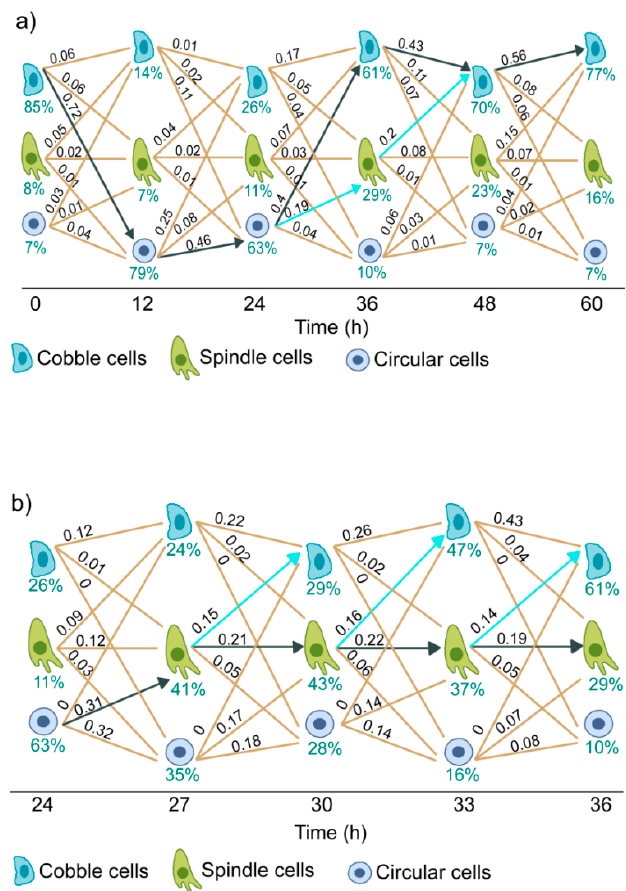
Figure 4. Cell state transition diagram of MDA-MB-468 cells treated with 10 ng/mL of EGF. Each line represents one state transition path. State transition parameters were estimated from the quantitative imaging data. Numerical values over the lines indicate the normalized flow of cells through those paths. Pointed black arrows show the dominant transition path and pointed blue arrows indicate the next dominant transition path. ( a ) State transition trajectories for observations at 12 h intervals till 60 h post-EGF treatment and ( b ) State transition trajectories for observations at 3 h intervals in the period of 24 to 36 h.